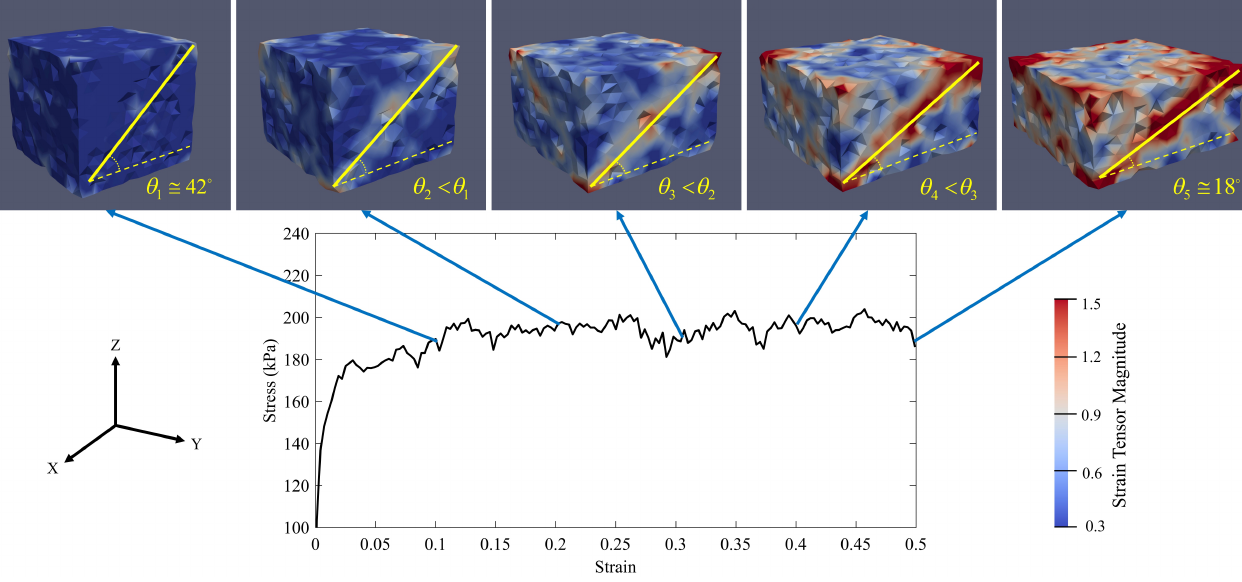
Figure 18. The evolution of micro-strain of specimen S 3 during the compaction process according to its stress-strain diagram ( P 0 = 100 kPa and ˙ (cid:101) 3 = 0.15 s − 1 , θ i = the angle between the localized band and the maximum principal stress